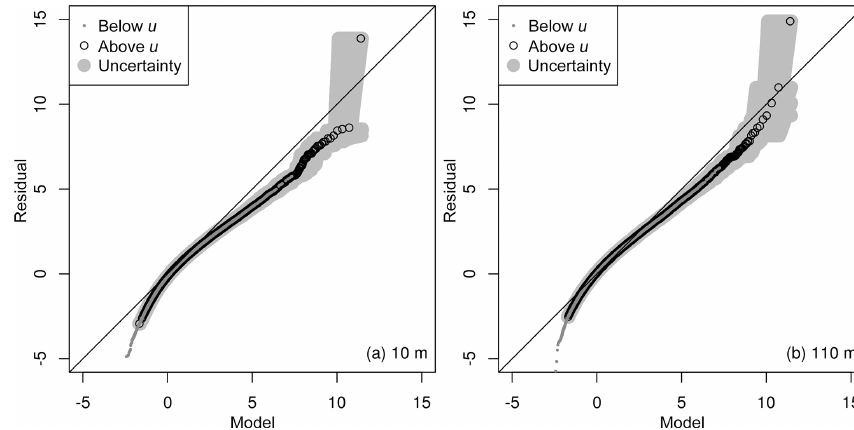
Figure 4. Q – Q plots for the Legendre model (a) at 10m and (b) at 110m with bootstrap uncertainty, as in Fig. 2.